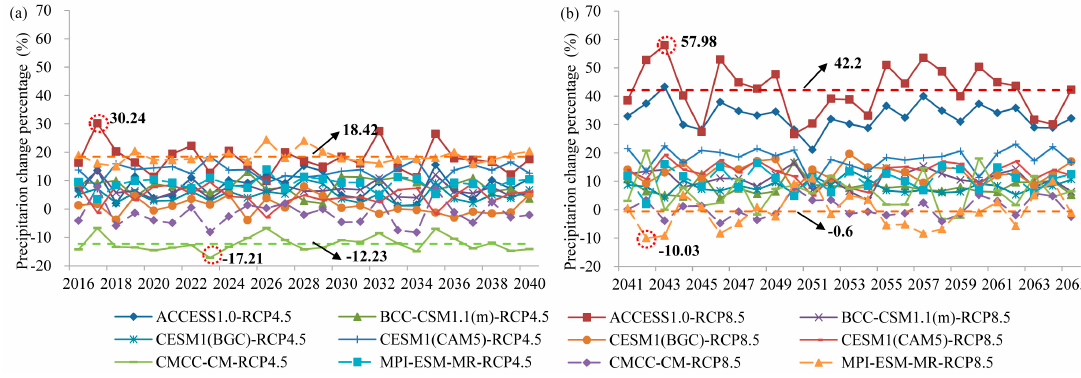
Figure 10. The forecasted precipitation change percentage relative to 1980–2004 period under CMIP5